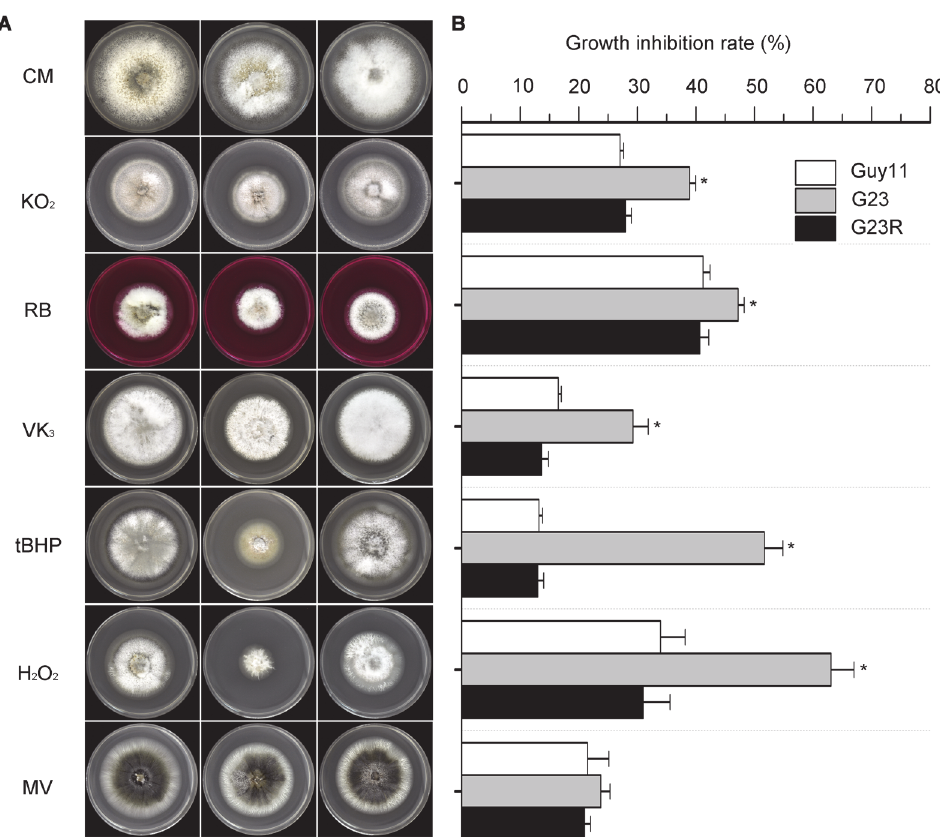
Fig 8. Effect of different oxidants on vegetative growth of the tested M . oryza e strains. (A) Vegetative growth of Guy11, MoSFA1 deletion and reintroduction mutants were grown on CM containing menadione (VK 3 , 100 μ M), potassium superoxide (KO 2 , 50 mM), rose bengal (RB, 100 μ M), tert-butyl- hydroxyperoxide (tBHP, 0.001%,v/v), and H 2 O 2 (0.04%, v/v) and Methyl viologen (MV, 0.25mg/ml) at 28°C for 6 days. (B) Growth inhibition rate of tested strains exposed to different oxidants. The experiments were performed in triplicate. ANOVA analysis was performed after growth inhibition rate were arcsine transformed. However, the original percentages were used for presentations. Error bars represent SD. Aasterisks in each data column indicate significant differences at p =